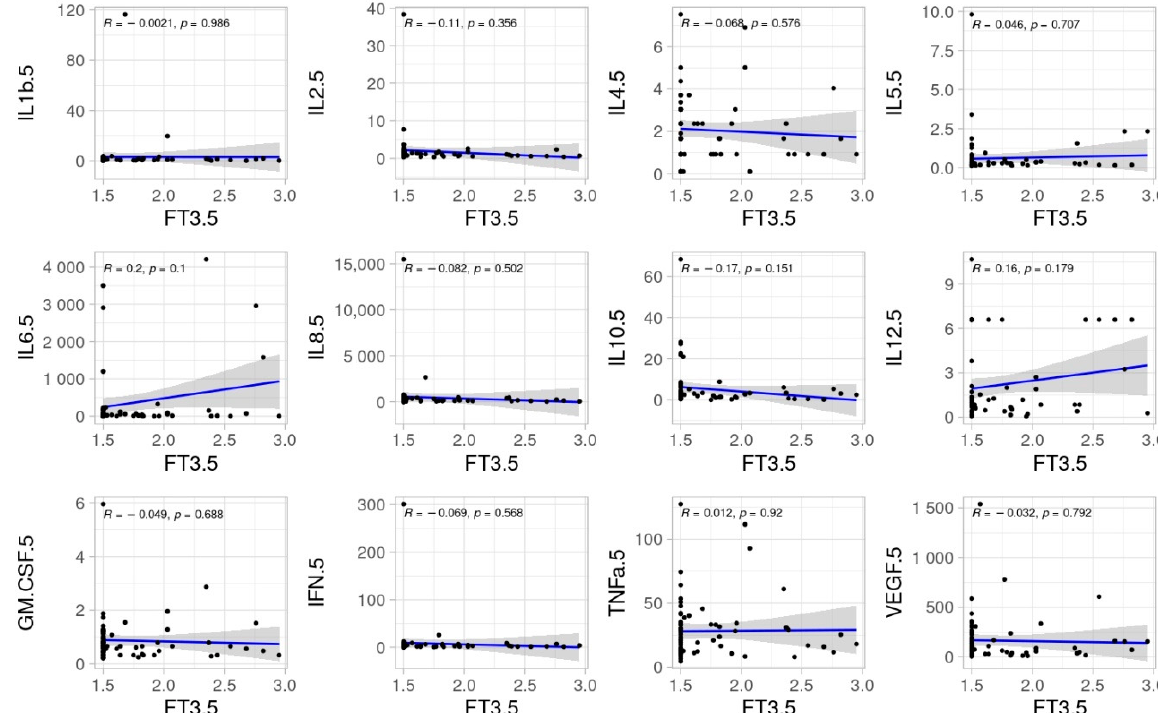
Figure 3. Scatter dots of correlations between fT3 and cytokines at day 5 .